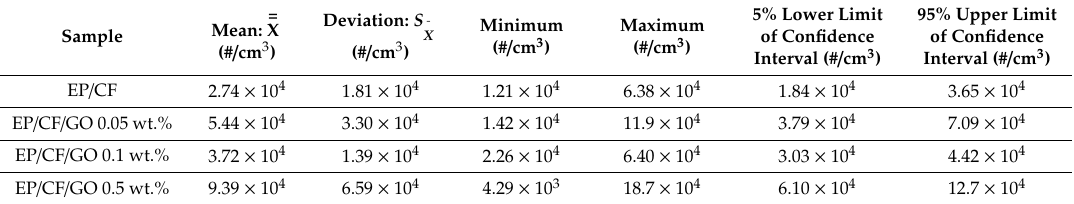
Table 1. Inferential statistical representation of the particle number concentrations introduced at the peaks due to the drilling on EP / CF-based samples reinforced with GO ( n = 24 for each sample). Lower and upper limits represent the 90% confidence interval on a sampling